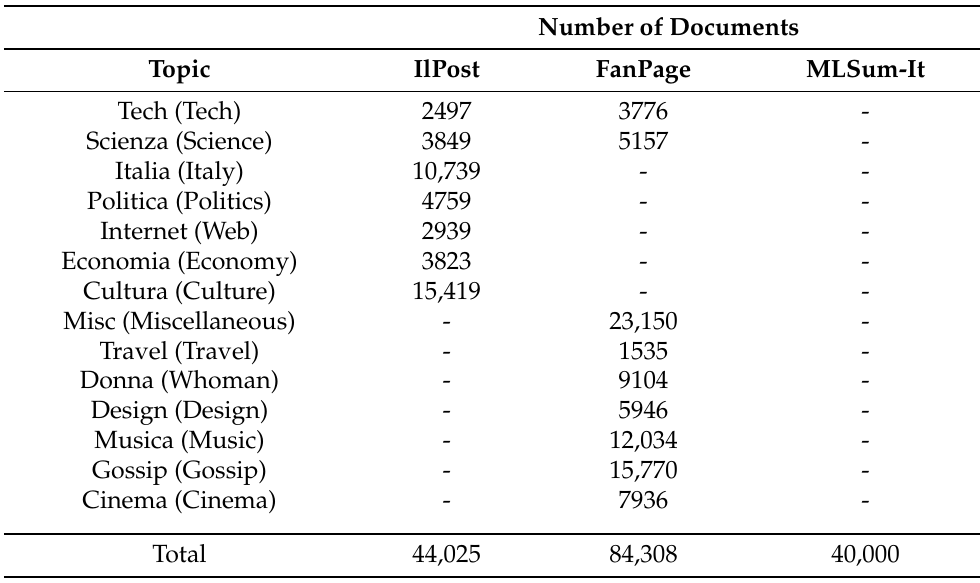
Table 2. Document cardinalities of the IlPost and Fanpage datasets, divided into different categories. The total cardinality is also reported for the two datasets and for the translated MLSum-It